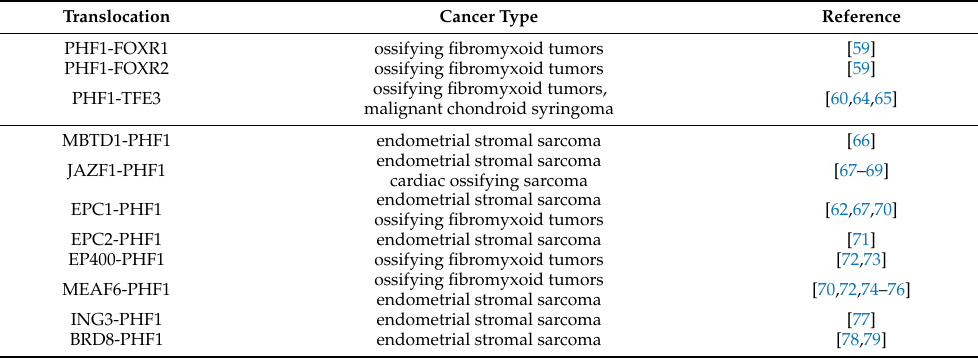
Table 1. Recurrent PHF1 gene rearrangements in cancer.